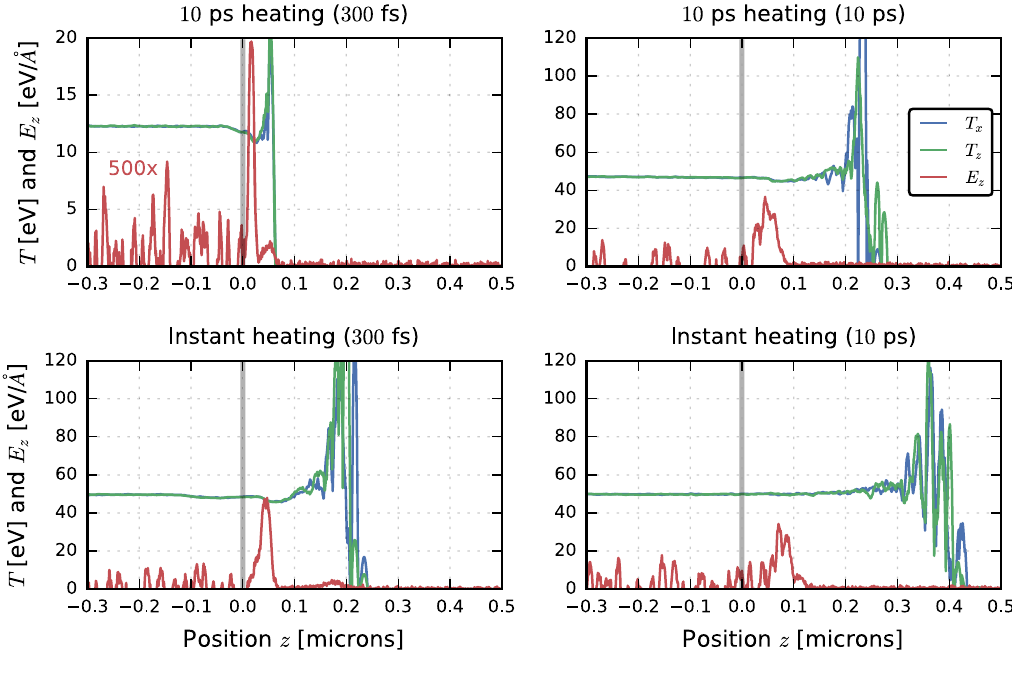
FIG. 11. Hydrogen temperatures and electric field. The electric field (red), which has been multiplied by a factor of 500 in each panel, and the parallel (blue) and perpendicular (green) temperatures are shown. A strong electric field is present near the location of the interface, which is slightly shifted from its original location (see Fig. 8). We see that the field begins to diminish by 10 ps. However, before that happens, the hydrogen is accelerated, as seen in Fig. (9), and begins to deposit its kinetic energy in the fuel, heating the fuel above the target temperature of 50 eV. Note that there are subtle, but insignificant, differences in the parallel and perpendicular temperatures, suggesting rapid thermal